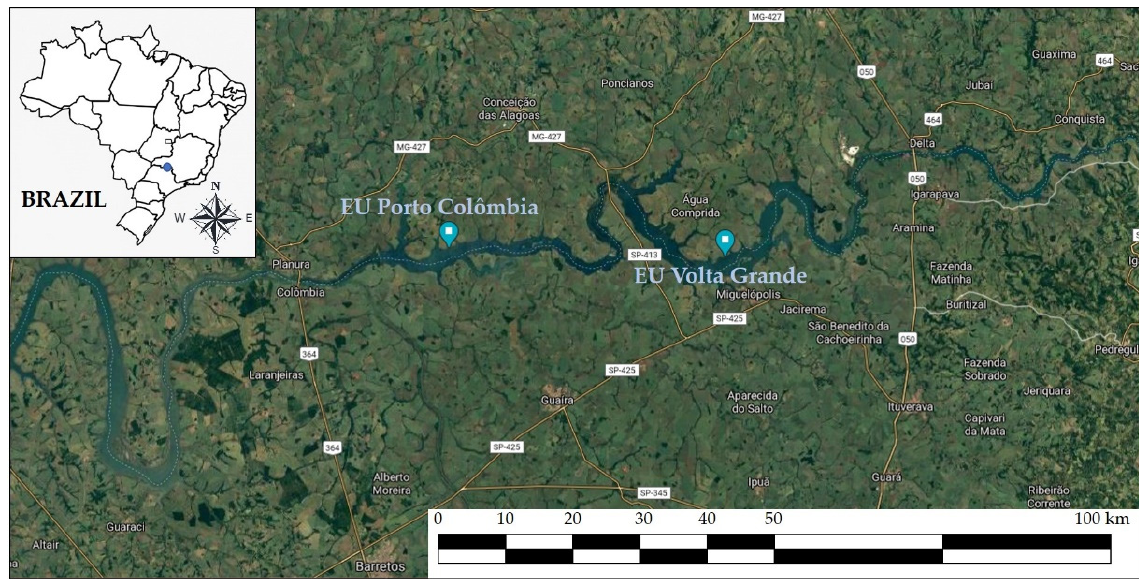
Figure 1. Location of the Experimental Units (EU) in the Hydroelectric Power Plants: Porto Colômbia (20°6 ′ 55.82 ′′ S; 48°28 ′ 9.07 ′′ W) and Volta Grande (20°7 ′ 38.86 ′′ S; 48°3 ′ 51.21 ′′ W).